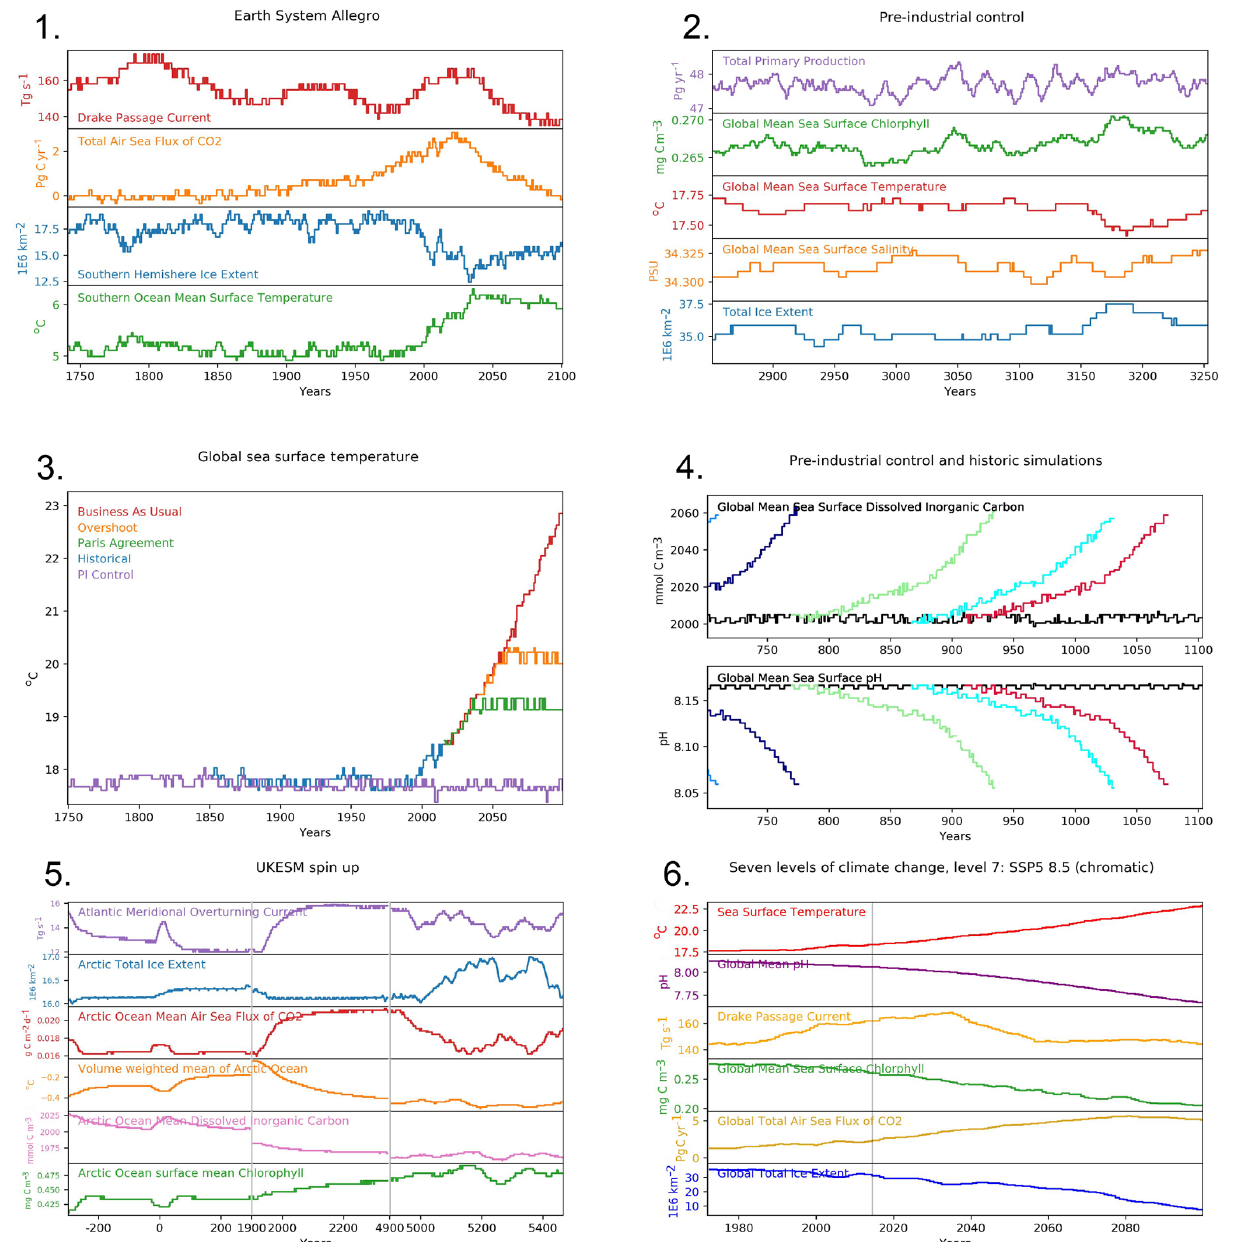
Figure 4. The final frame of each of the six videos. The frames of the videos are shown in the order that they were published. The videos (1) , (3) , (5) and (6) use a consistent x axis for the duration of the video, but videos (2) and (4) have rolling x axes that change over the course of the video. This means that panels (2) and (4) show only a small part of time range. Panel (5) includes two vertical lines showing the jumps in the spin-up piece. Panel (6) shows a single vertical line for the crossover between the historical and future